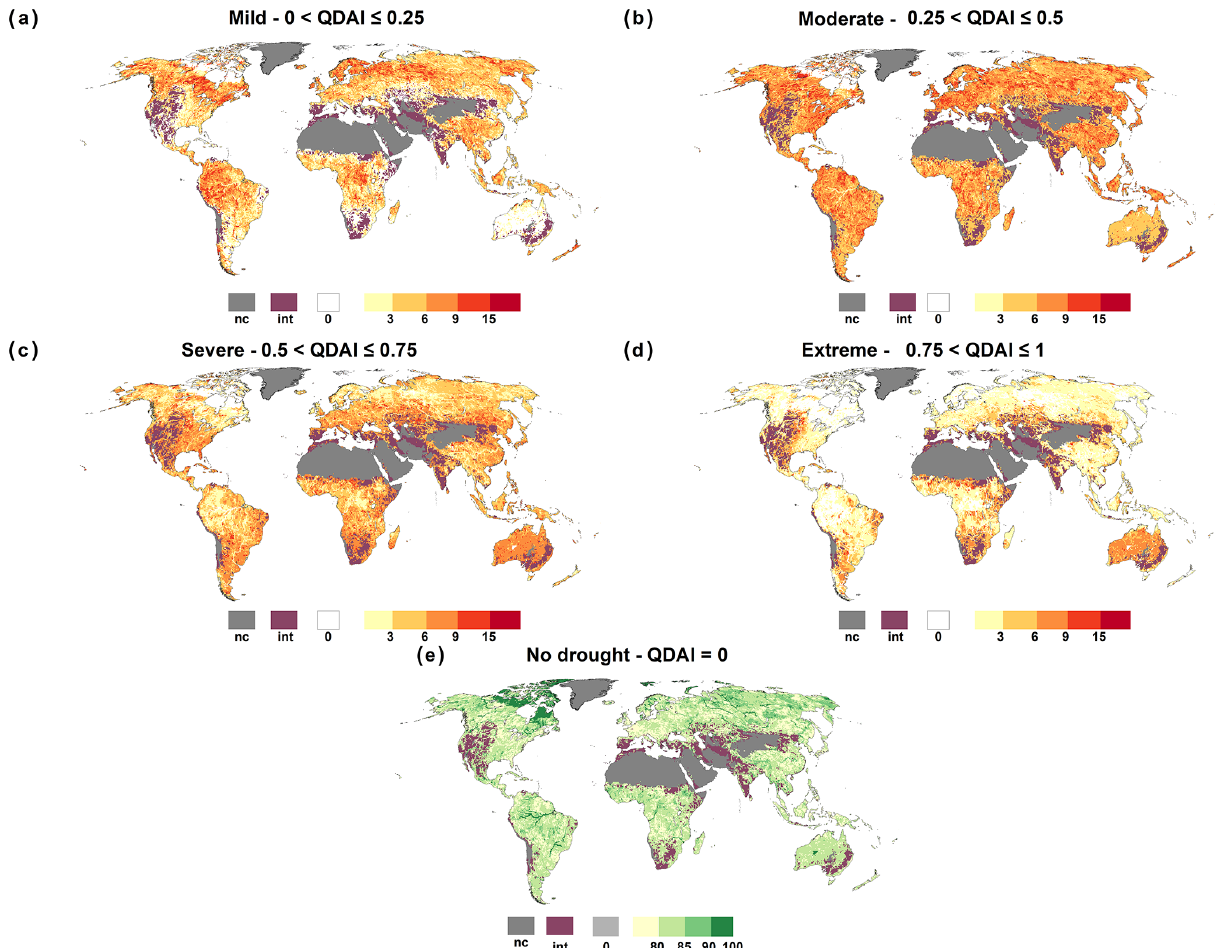
Figure 6. Frequency of occurrence [%] of different streamflow drought classes during the period 1981–2010 as defined by QDAI (Table 2). Grid cells where for any calendar month there are at least 6 months with Q ant = 0 are indicated as int, and grid cells which are not computed due to land cover are indicated as